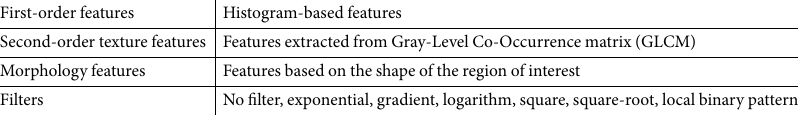
Table 2. List of radiomic feature classes and